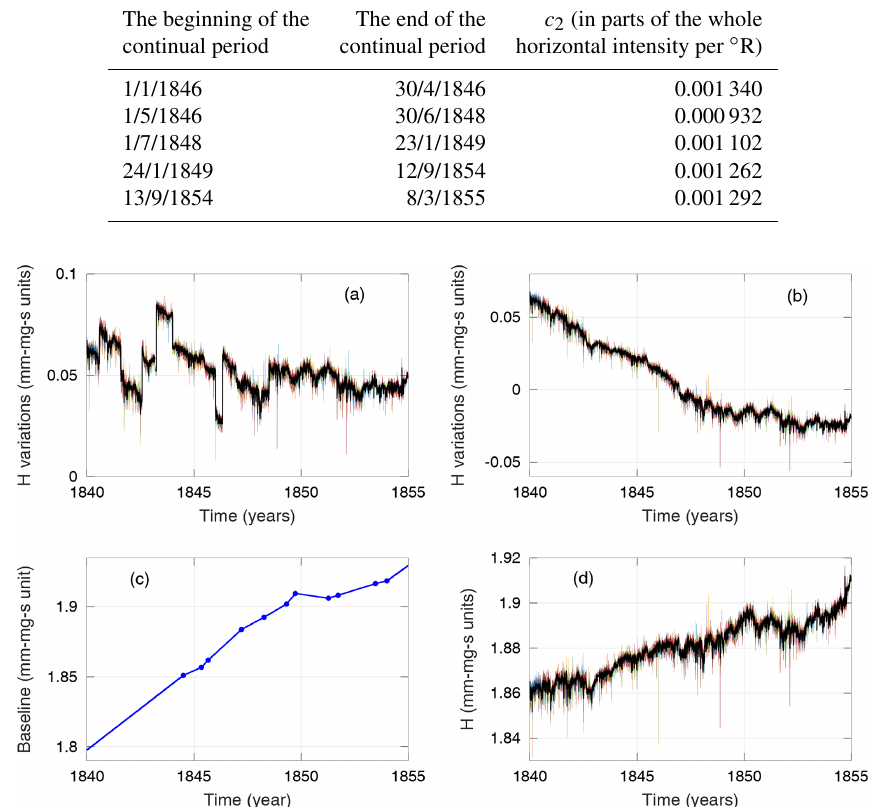
Figure 5. The horizontal intensity in Prague (Clementinum) from the beginning of 1840 until the end of 1854. (a) The variations, as recorded in the yearbooks, converted to the physical unit of the mm–mg–s (millimetre, milligram, and second) system introduced by Gauss. Discontinuities that arose at the time when the settings of the bifilar apparatus were performed are not yet removed from the time series. The discontinuity between 1845 and 1846 arose from the replacement of the old apparatus with a new one. The values measured at different parts of the days are plotted in different colours. The average daily values are shown by a thicker black curve. (b) The time series after the removal of the discontinuities. (c) The baseline of the instrument that was used for measuring the variations in the horizontal intensity. (d) Time series of absolute values of the horizontal intensity at the Clementinum observatory for the period